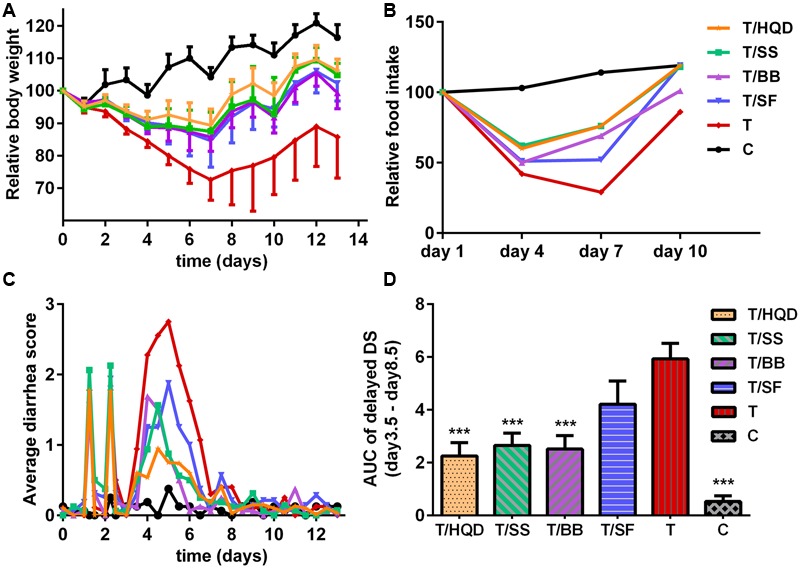
Effect of TCM (HQD, SS, BB, or SF decoctions) on CPT-11-induced toxicity in rats. (A) Effects of TCM in protecting against weight loss induced by CPT-11. The change in body weight was calculated on the basis of that on day –1. Each point represents the mean of 8–10 animals. (B) Effects of TCM in protecting against food-intake reduce induced by CPT-11. (C) Effects of TCM in protecting against diarrhea induced by CPT-11. (D) Area under the curve (AUC) of delayed diarrhea score (DS) (days 3.5–8.5). ∗∗∗p < 0.001 vs. T group. Details of experimental procedures are given in section “Materials and Methods.” SS, single S. baicalensis; BB, baicalin and baicalein; SF, S. baicalensis free; T, CPT-11.